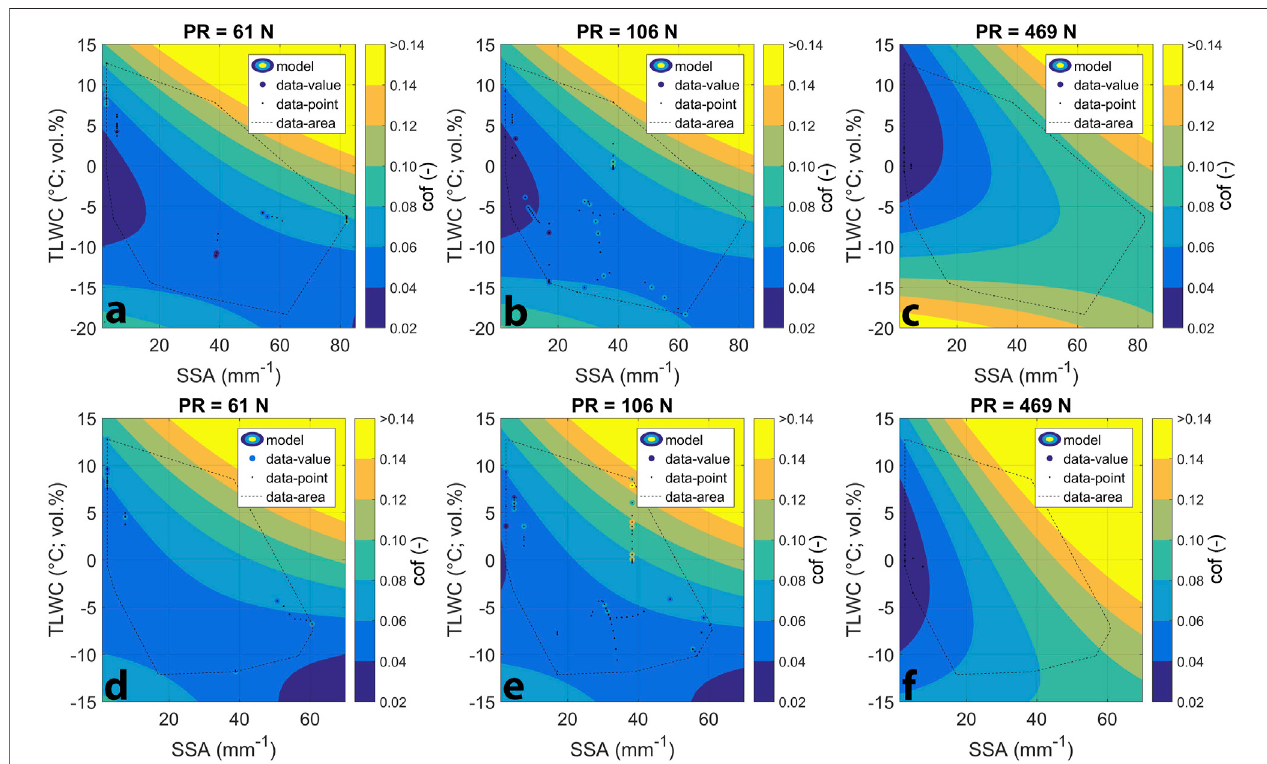
FIGURE 8 | COF contour maps of skiers (A – C) and snowboarders (D – F) visualizing multivariate models of the COF – snow property relationship for low (A,D) , mid (B,E) , and high (C,F) PRs. The measured COF values are visualized by small black dots revolved by larger fi lled circles ( (cid:1) 1 run). If the measurement ( fi lled circle) has the same value (color) as the model (background), only the small black dot is visible.